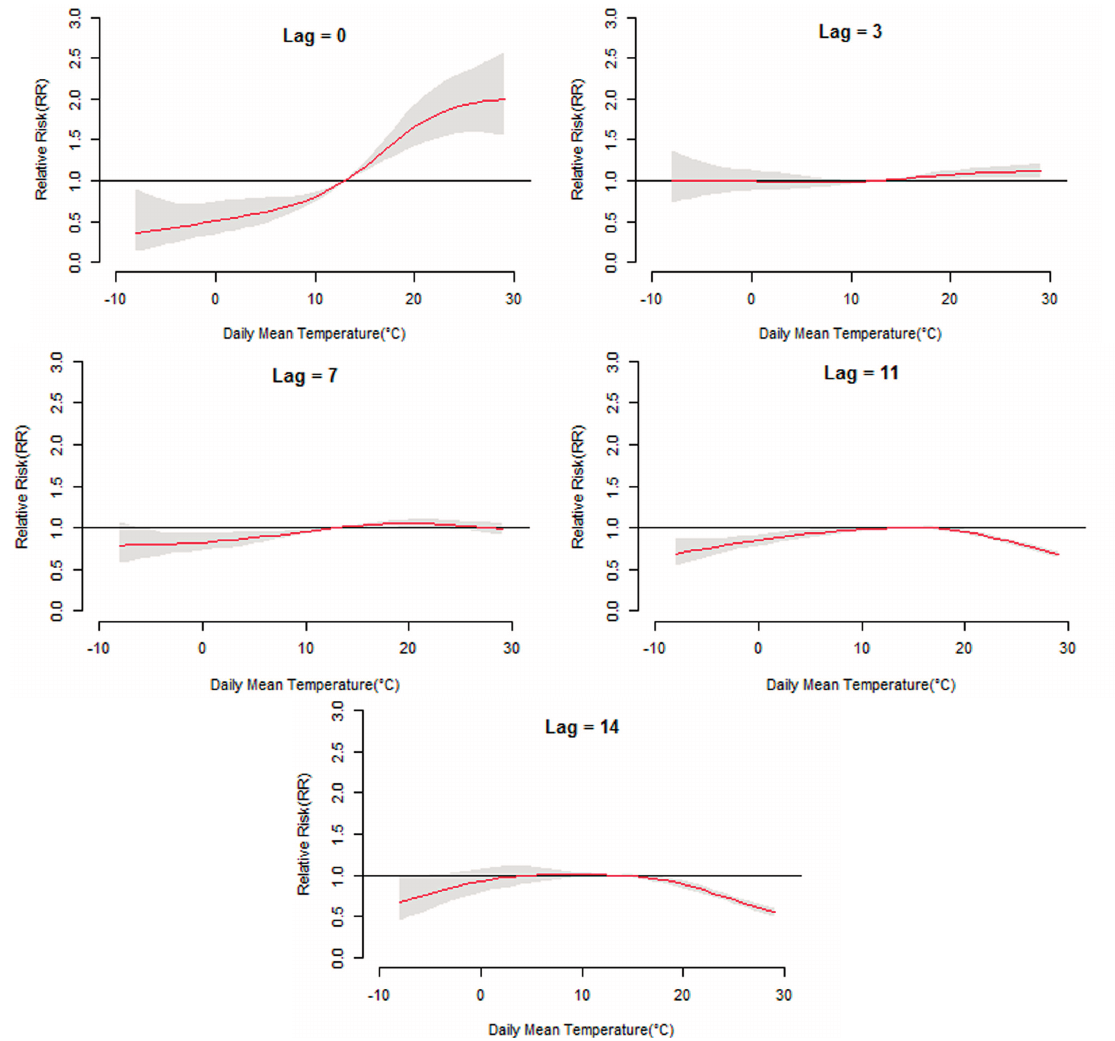
Figure 4. The relative risk of HFMD by daily mean temperature at a specific lag day (0, 3, 7, 11, and 14 days) in Jinan. The maximum likelihood estimate of RRs is shown as smooth red lines and the pointwise 95% confidence intervals are shown in the gray regions.